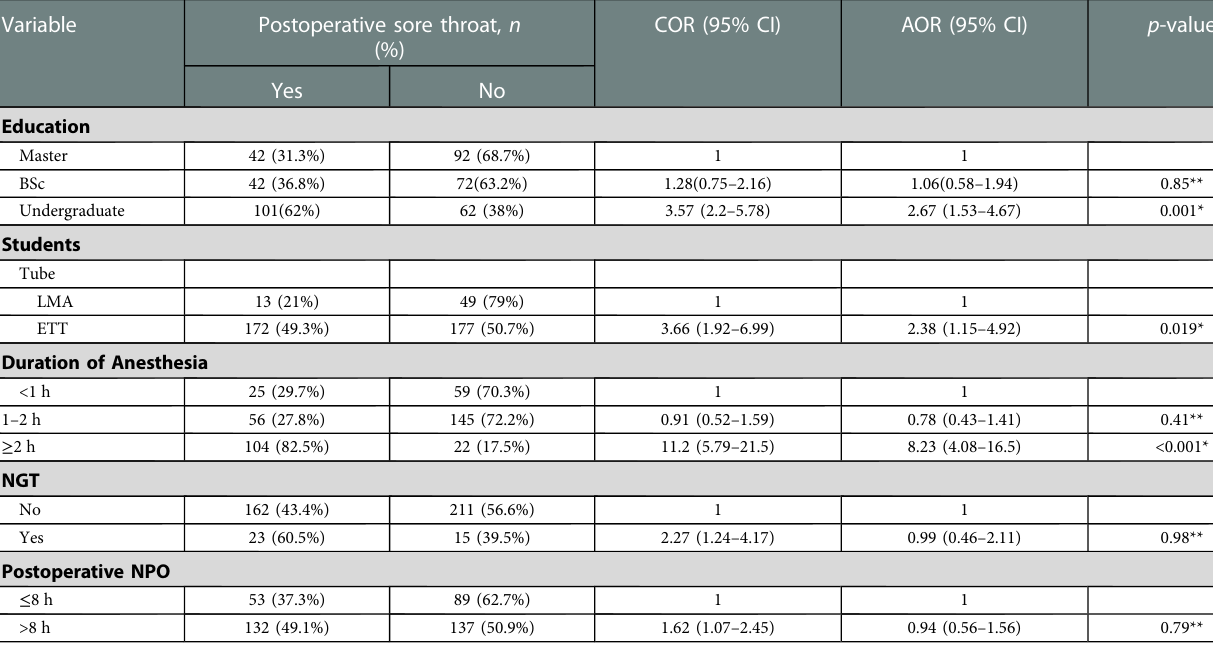
TABLE 4 Bivariate and multivariate logistic regression for POST among pediatric patients at northwest amhara referral hospitals, from march 1 to June 30, 2022( N